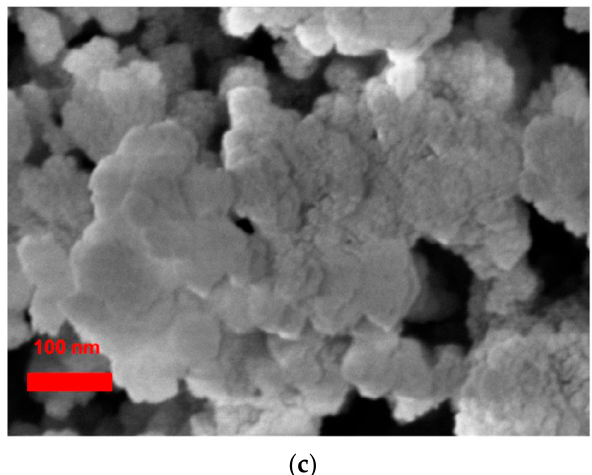
Figure 2. SEM images of ( a ) H-beta ( b ) TiO 2 particles dispersed on H-beta ( c )THB composite.